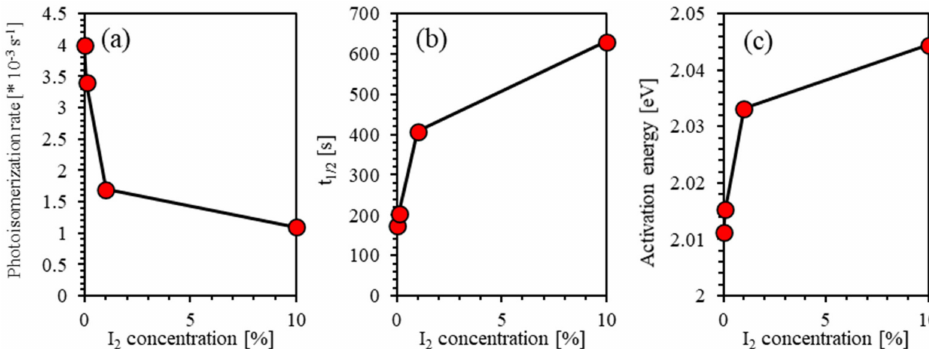
Figure 12. Photoisomerization rate, half-life of the trans -phase into cis -phase ( τ 1/2 ), and activation